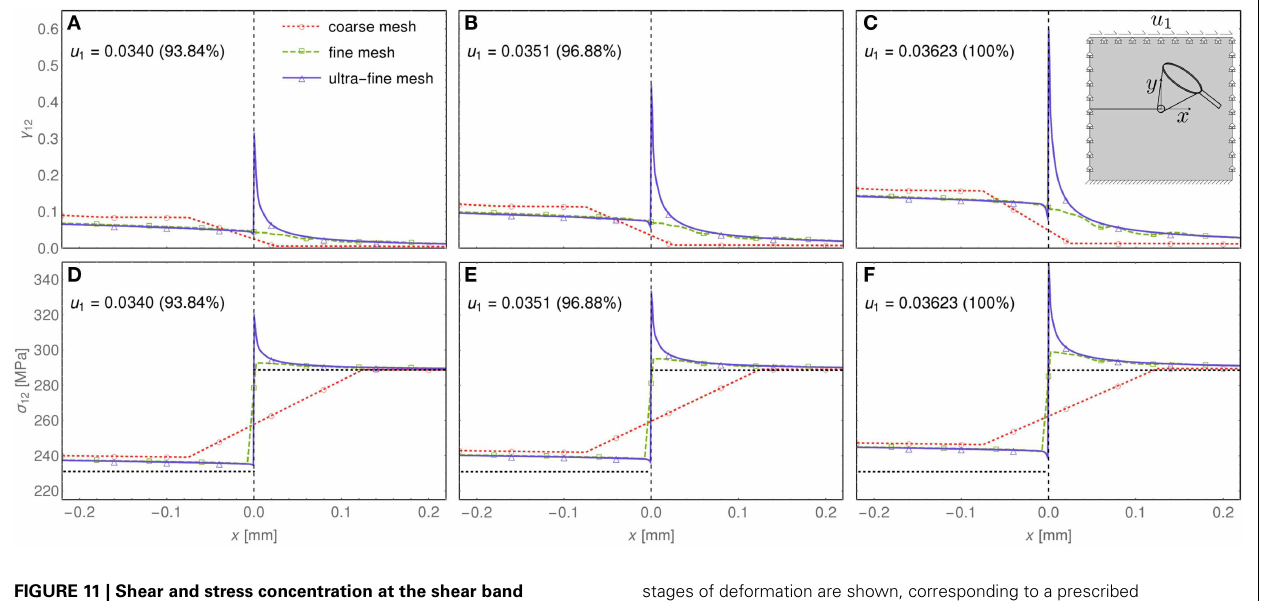
stages of deformation are shown, corresponding to a prescribed displacement at the upper edge of the square domain